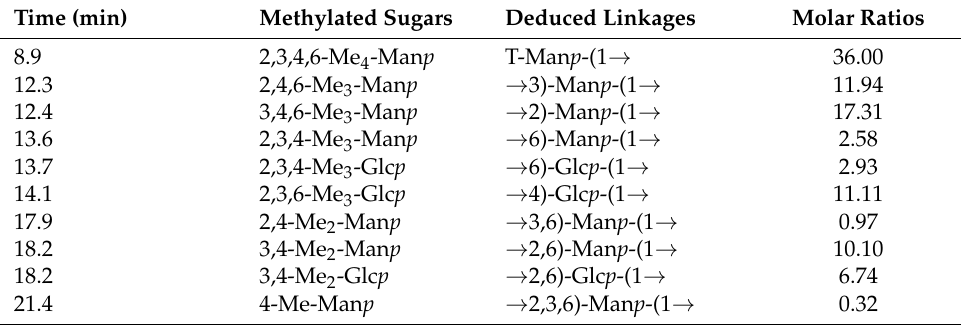
Table 2. Glycosidic linkage composition of methylated LPB8-1 by GC–MS